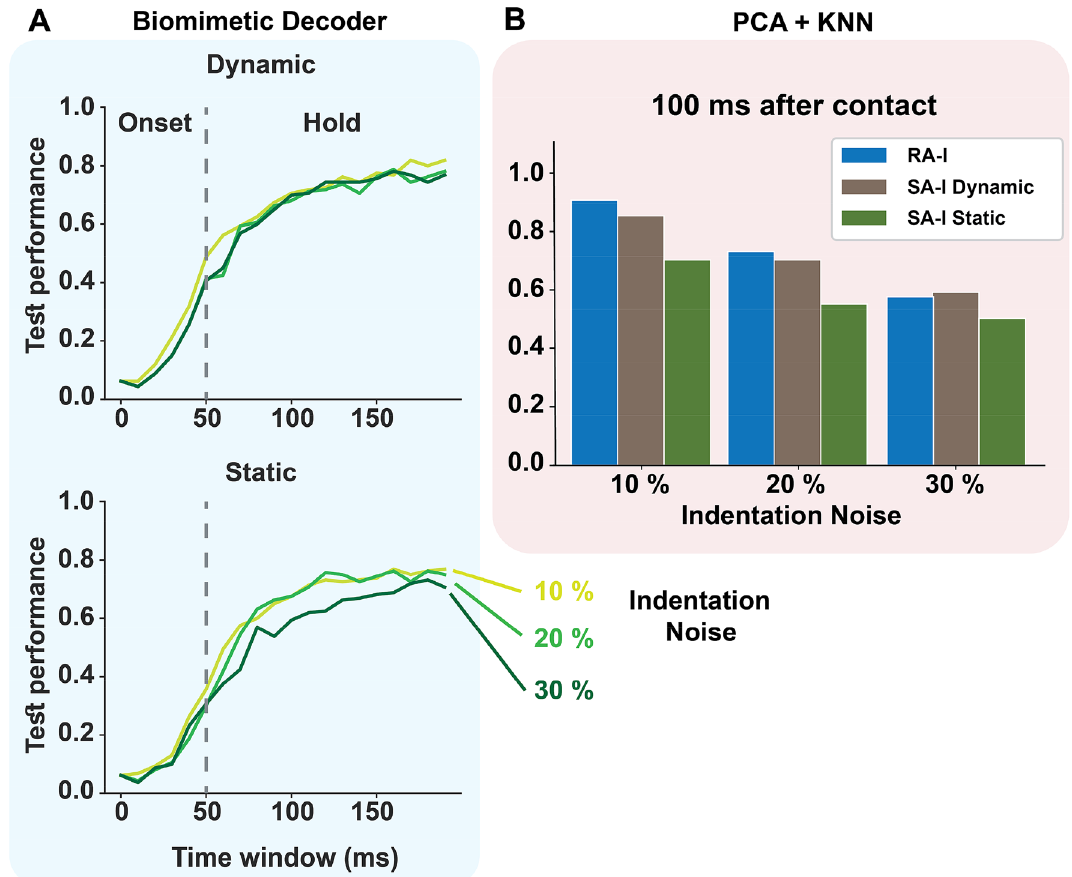
Figure 2. Network performance comparison for the static and dynamic models of SA-I afferent based on spike count analysis. ( A ) The biomimetic decoder is robust to noise for both static and dynamic models. ( B ) The KNN classification performance utilizing the first 3-principal components from afferent responses (RA-I, SA-I Dynamic, and SA-I Static models) to recognize orientation stimuli 100 ms after contact for three levels of indentation